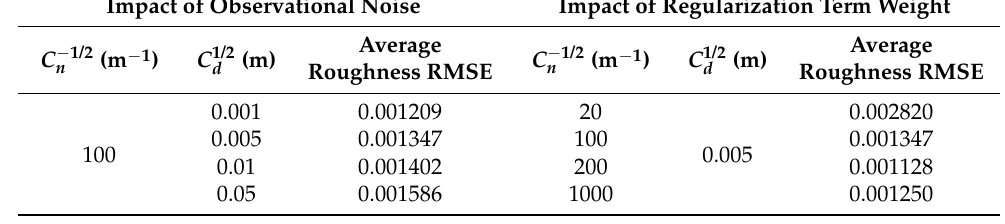
Table 4. Average roughness RMSE with different observational-noise levels and regularization weights.